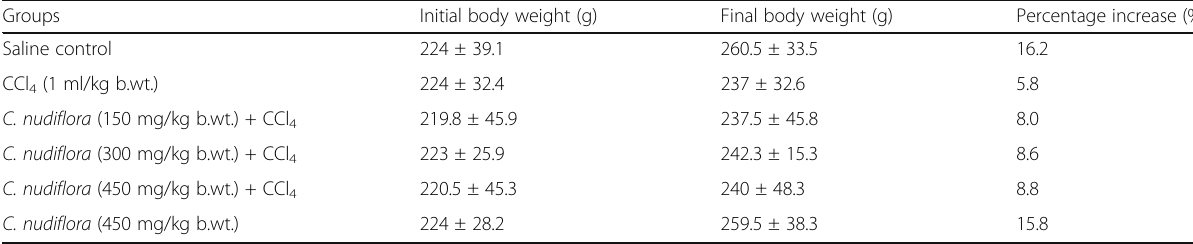
Table 2 Effect of C. nudiflora on body weight